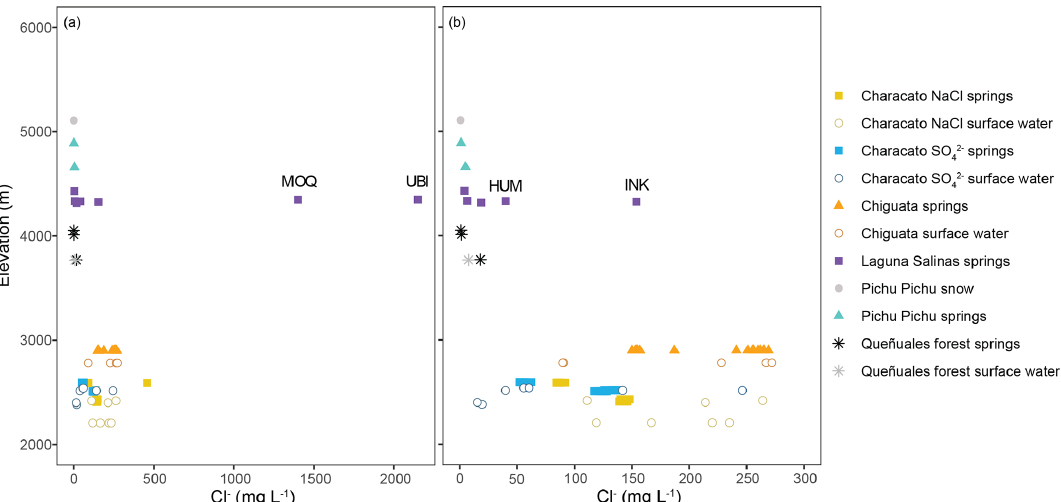
Figure 7. Chloride concentration of all water samples at different elevations, (a) excluding Laguna Salinas surface water and (b) excluding two Laguna Salinas springs (UBI and MOQ) with high Cl −